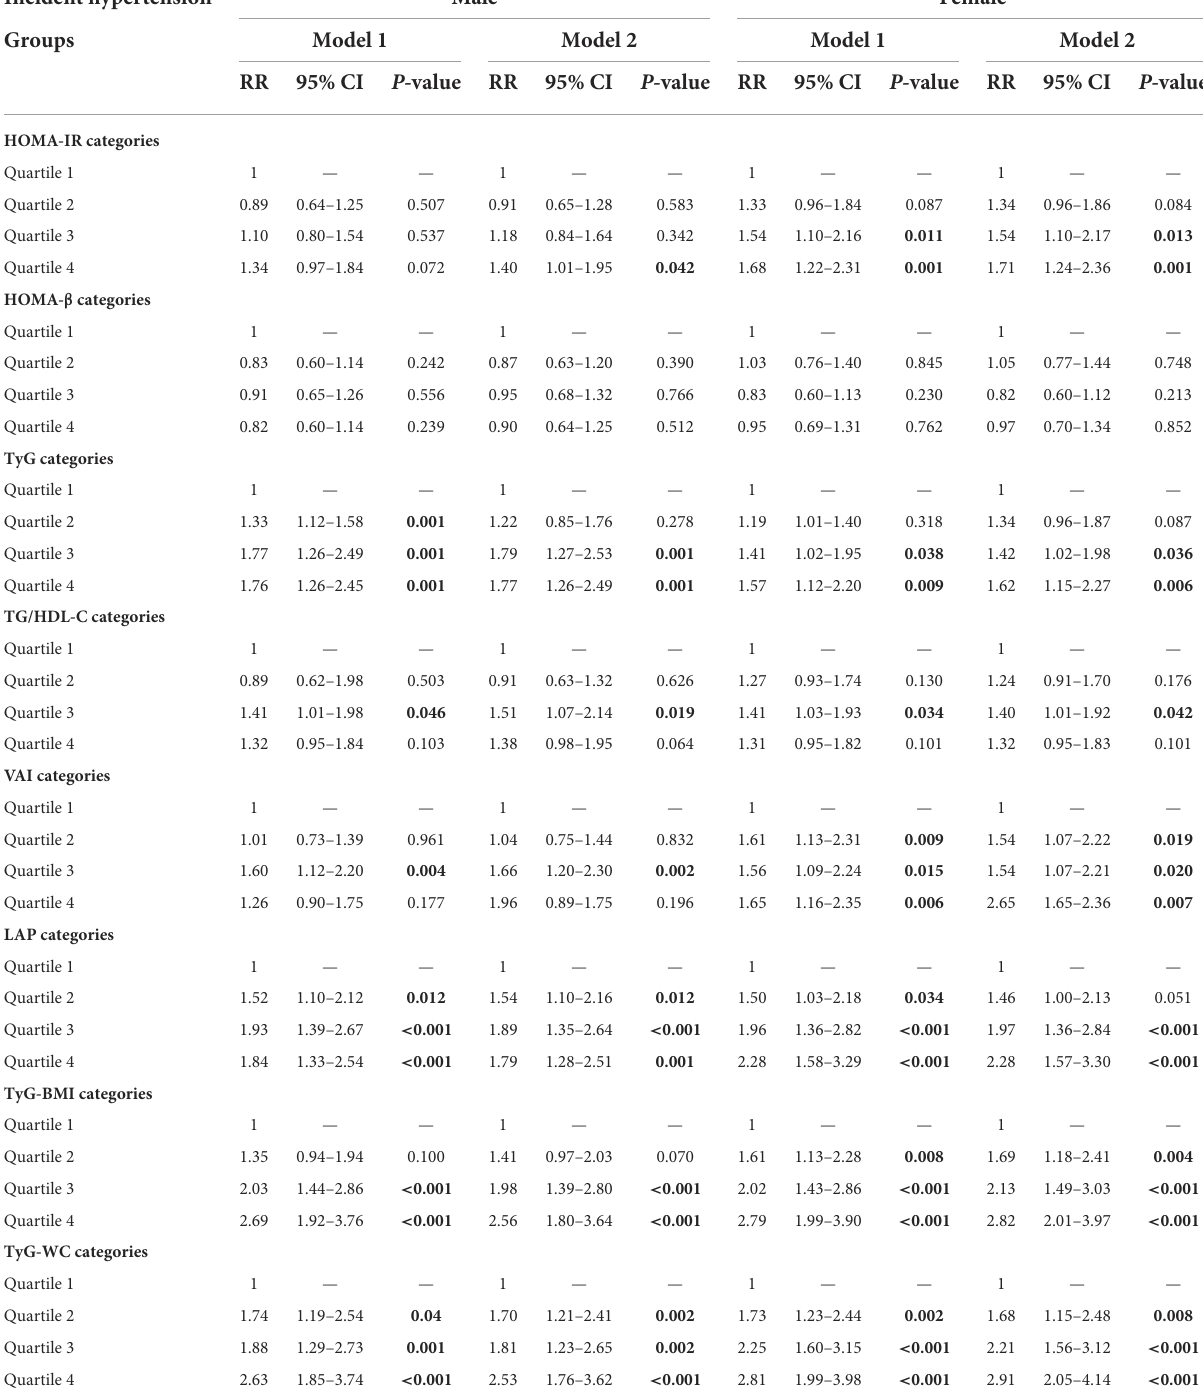
TABLE 3 Risk ratios and 95% confidence intervals of the association of IR categories and its surrogate index with incident hypertension by gender. Incident hypertension Male Female Groups Model 1 Model